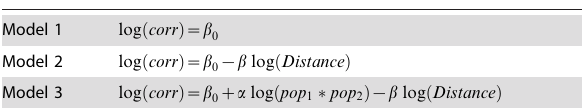
Table 2. Model summary.